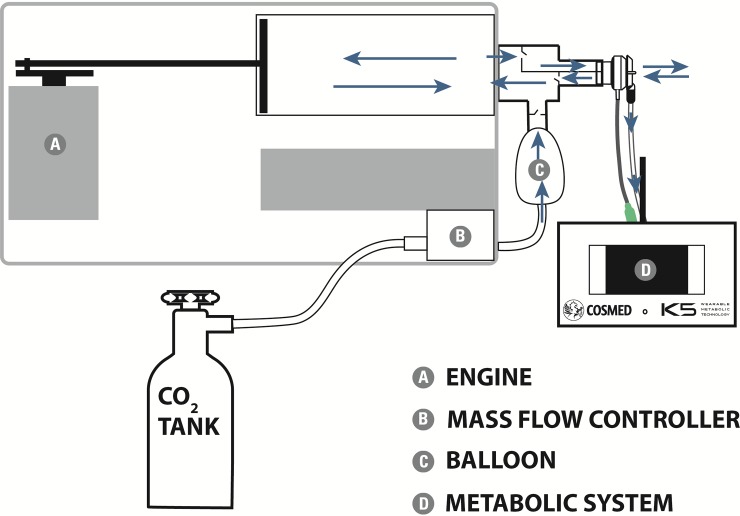
Schematic of the COSMED K5 and VacuMed systems.